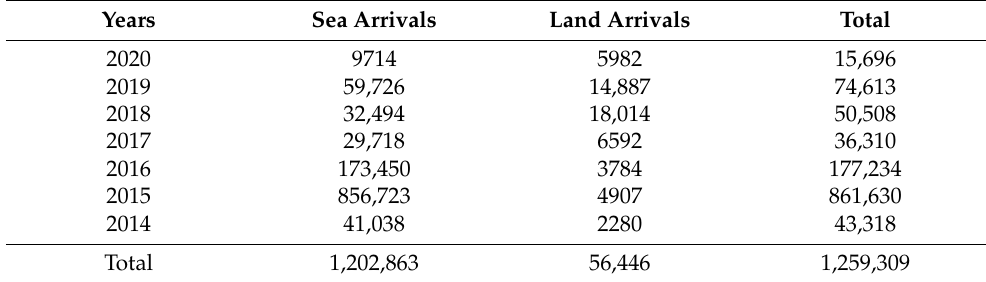
Table 2. Sea and land arrivals 2014–2020 according to